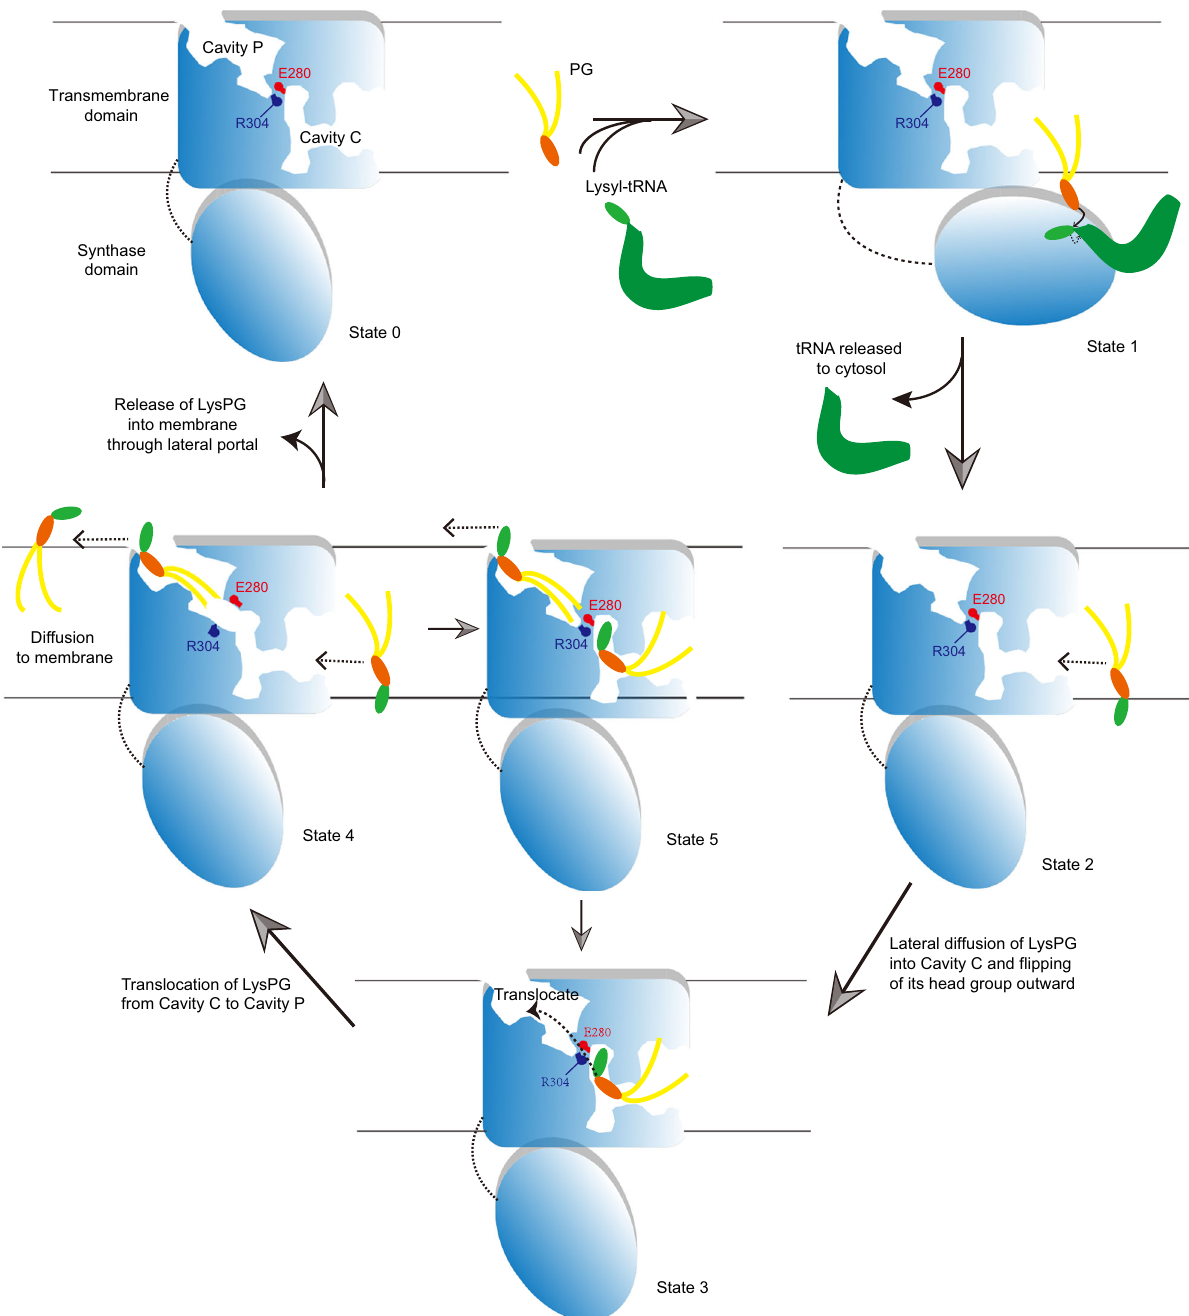
Fig. 5 A mechanistic model of LysPG synthesis and translocation mediated by MprF. While each monomer in the homodimer may mediate the entire cycle of LysPG synthesis, translocation and release independently, the other monomer may also serve to stabilize the adjacent one in the optimal position (relative to lipid bilayer) for synthesis and translocation of LysPG. The cavities and Arg304 – Glu280 pair are only shown in the active monomer and the other monomer is left out for clarity. State 0 represents a resting state of MprF. At State 1, the curved solid arrow indicates the nucleophilic attack of the PG head-group hydroxyl on the activated α -carbon of lysyl-tRNA and the dash arrow denotes the break of covalent bond between lysyl group and tRNA. At States 2 and 4, the dash arrows indicate the lateral diffusion of LysPG into and out of the cavities in Rt MprF. Loading of LysPG into Cavity C leads to State 3 as observed in the Rt MprF(DDM)-nanodisc structure. During the transition from State 3 to State 4, a channel connecting Cavity C and Cavity P may emerge transiently to facilitate translocation of LysPG. When the Cavity C in State 4 is re fi lled with a second LysPG molecule, both cavities are occupied by LysPG as observed in the Rt MprF(GDN)-nanodisc structure (State 5). Further releasing of LysPG from Cavity P to the membrane leads to switching of State 5 to State